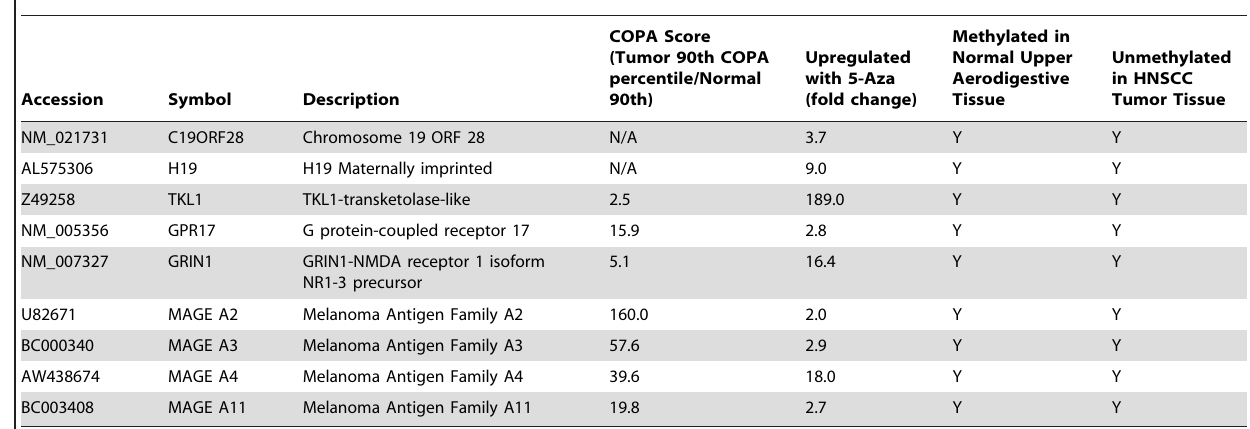
Figure 2. Promoter methylation status in primary tissues. ( a ) Shown are the bisulfite sequencing results in 10 tumors and 10 normals for: TKTL1 (4/10, p , 0.05), H19 (6/10, p , 0.05), MAGEA2 (5/10, p , 0.05), MAGEA3/6 (5/10, p , 0.05), MAGEA4 (5/10, p , 0.05), MAGEA11 (5/10, p , 0.05), GPR17 (3/10, p , 0.10), GRIN1 (6/10, p , 0.05), C19ORF28 (5/10, p , 0.05). ( b–j ) QRT-PCR expression with the bisulfite sequencing of the respective promoter below (white is unmethylated, grey is methylated). Significance was measured by comparison of expression of methylated to unmethylated by Mann- Whitney U test. Significance was found in MAGEA2 (p=0.007), MAGEA3/6 (p=0.007), MAGEA11 (p=0.05). Strong associations between expression and promoter methylation status were also found for TKTL1 (p=0.06), MAGEA4 (p=0.09), C19ORF28 (p=0.09), GRIN1 (p=0.06). H19 (p=0.7)